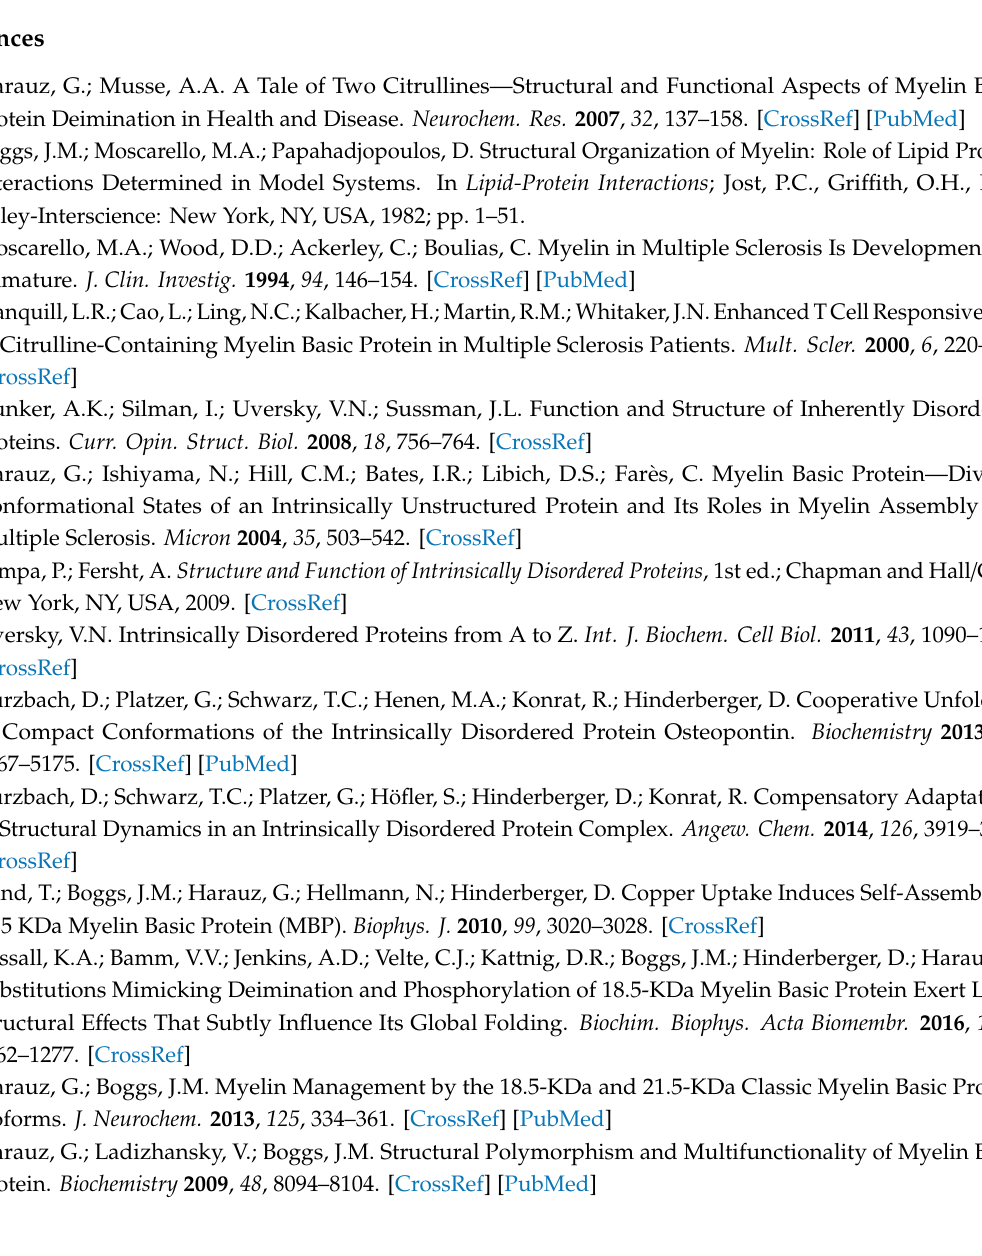
Figure S8: Comparison of all mixtures with and without MBP at approximately 10 mN / m, Figure S9: Fluorescence microscopy images of all lipid mixtures used, with and without MBP, Figure S10: Fluorescence microscopy images with a 20 × magnification